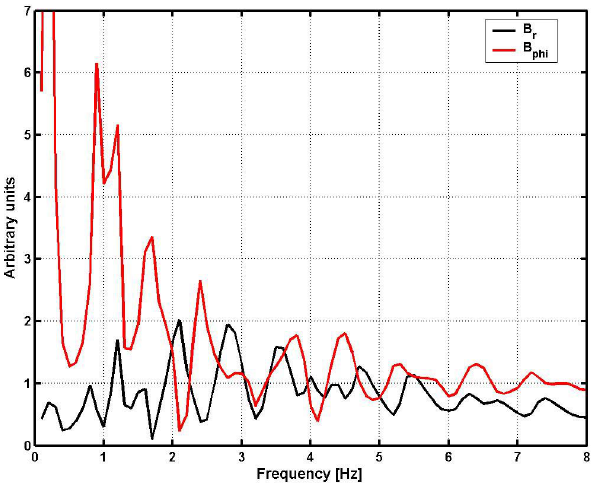
Fig. 3. Same as Fig. 2 but for φ =20 ◦ . For more details see text. Fig. 4. A power spectrum of the H- and D-component as observed